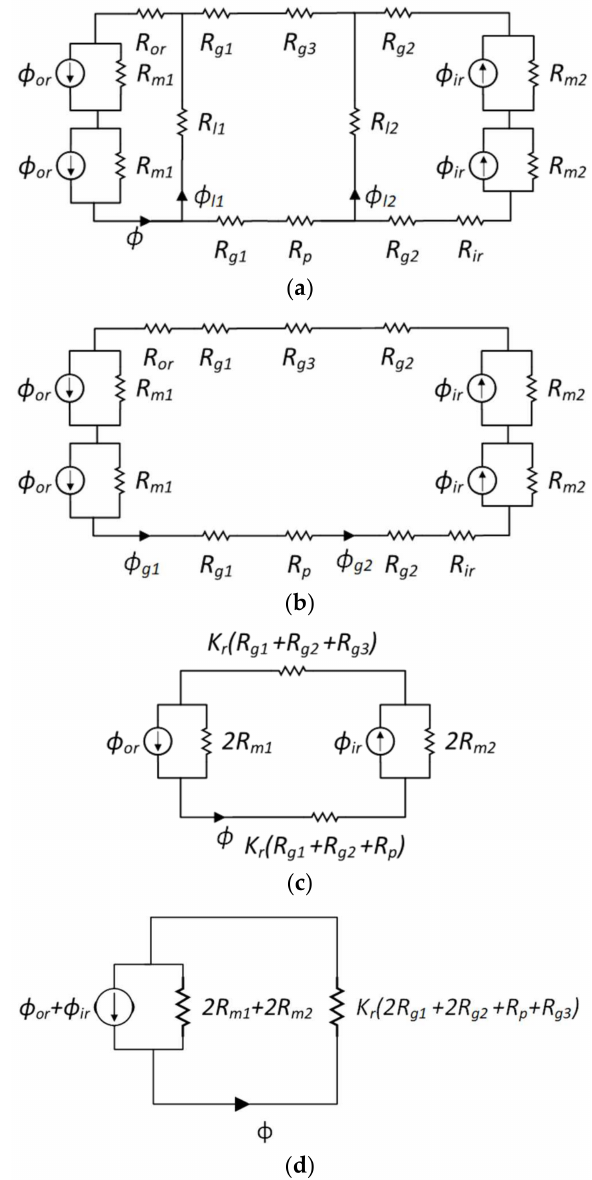
Figure 5. Simplification of unit block circuit: ( a ) swapping the R or and R ir , ( b ) eliminating the magnet and leakage reluctances, ( c ) eliminating the R or and R ir , ( d ) swapping and simplifying the